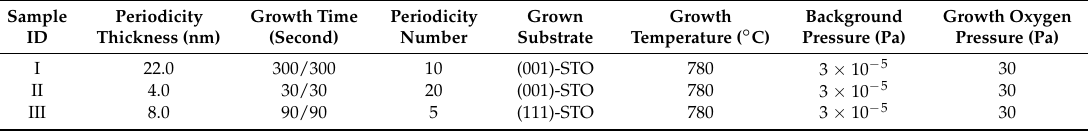
Table 1. The sample-parameters and synthesis conditions of three LaFeO 3 -YMnO 3 (LFO-YMO) multilayers (samples I–III) characterized by transmission electron microscopy in this work. The